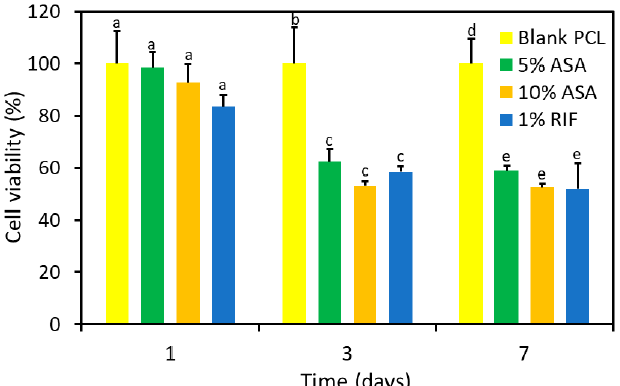
Figure 8. Viability of Balb/3T3 fibroblast after 1, 3 and 7 days in contact with 5% ( w / w ) ASA, 10% ( w / w ) ASA, 10% ( w / w ) ASA and 1% ( w / w ) RIF and blank PCL control samples. Different letters denote statistical differences ( p < 0.05) within the same timepoint.